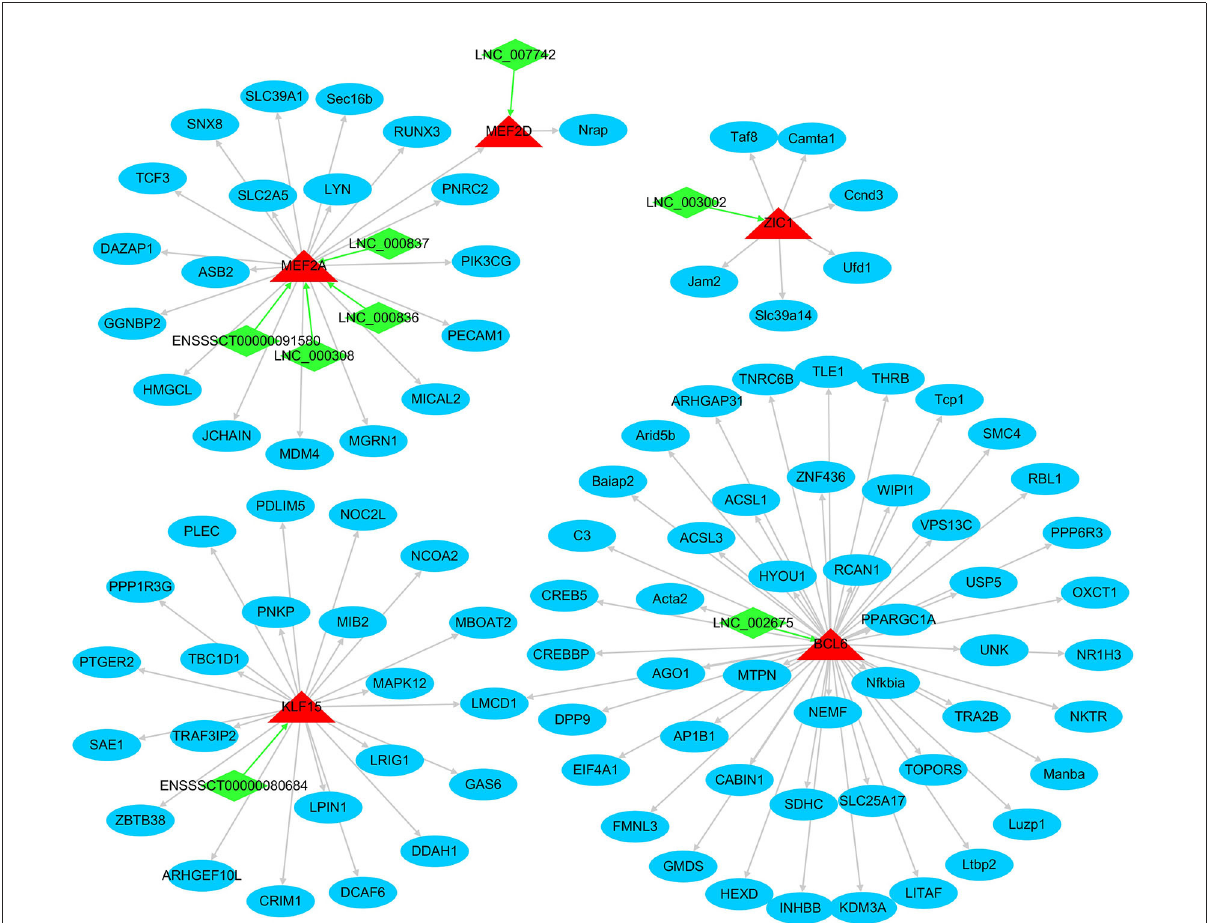
FIGURE7 The network formed by fat deposition (FD)-differentially expressed transcription factors, FD-differentially expressed lncRNAs, and FD-differentially expressed genes. Arrows indicate the target direction. The green quadrilateral represents lncRNA, the red triangle represents TF, and the blue circle represents